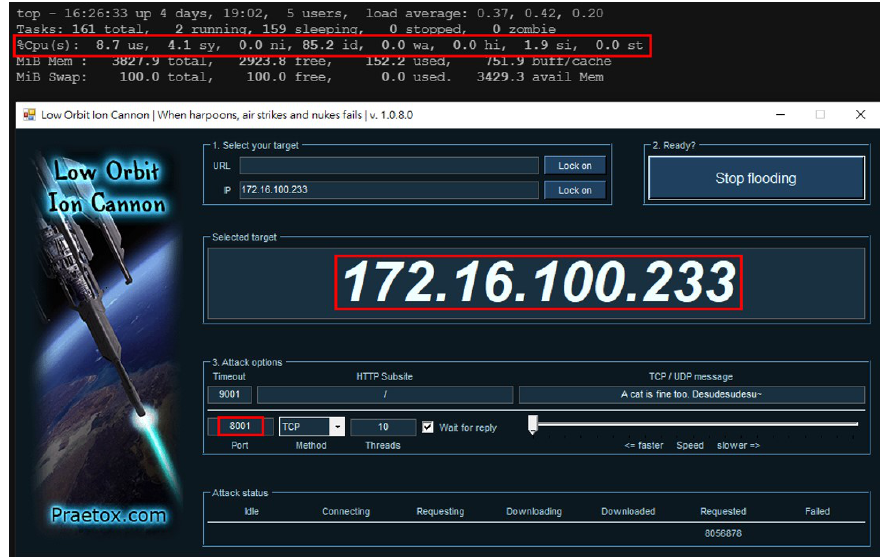
Figure 10. SCADA server with TEVM